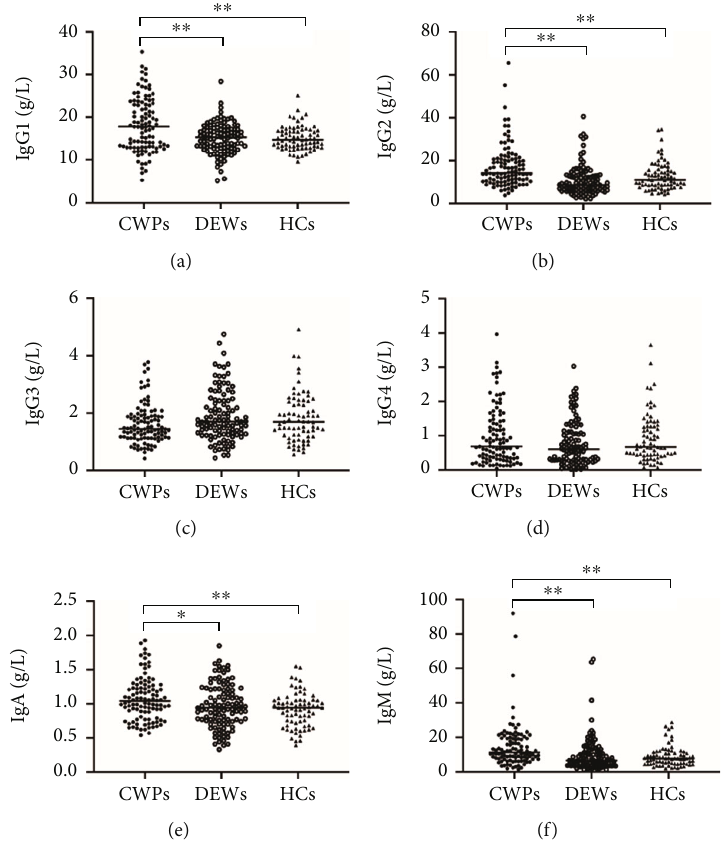
Figure 1: Comparison of serum concentrations of IgG1, IgG2, IgG3, IgG4, IgA, and IgM among the study groups. (a) IgG1, (b) IgG2, (c) IgG3, (d) IgG4, (e) IgA, (f) IgM. ∗ P < 0 : 05 ; ∗∗ P < 0.01. CWP: coal workers ’ pneumoconiosis; DEWs: dust-exposed workers; HCs: healthy